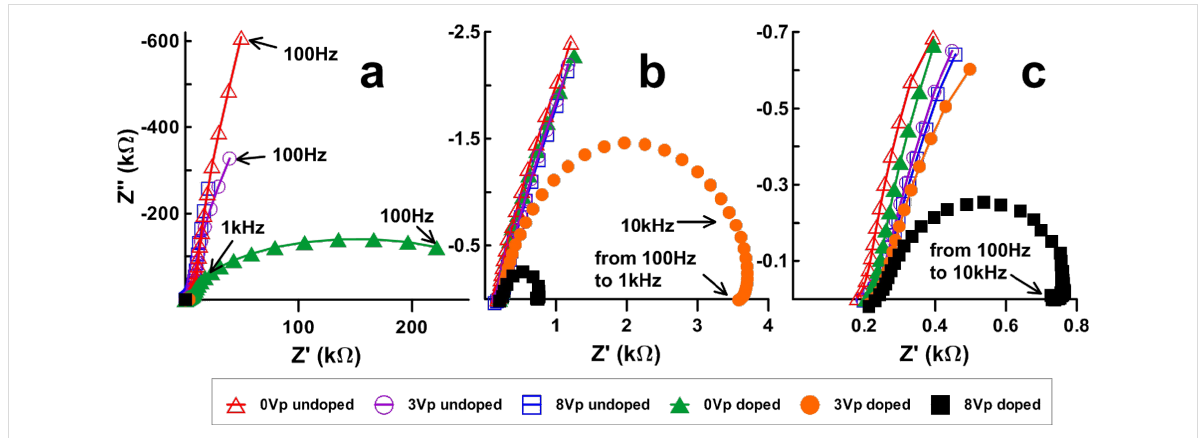
Figure 4: Cole-Cole plots of the undoped and MWCNTs-doped LC cells at different scales. (a), (b) and (c), impedance evolution with the reorienta- tion of LC molecules (0, 3 and 8 V bias voltages).